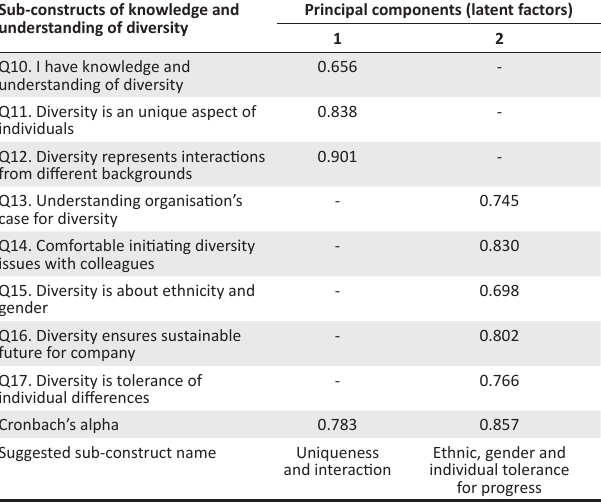
TABLE 2: Exploratory factor analysis of the sub-construct of knowledge and understanding of diversity. Sub-constructs of knowledge and understanding of diversity